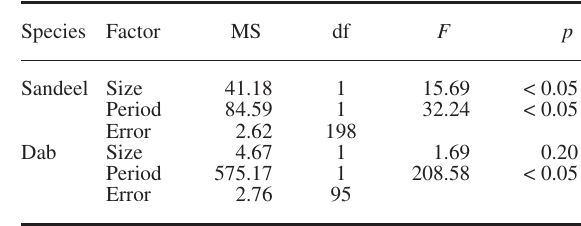
T ABLE 1. – Summary of the analyses of covariance (ANCOVA) on larval δ 15 N, the period of the sampling and larval standard length as covariable. Standard lengths of larval sandeel smaller than 200 µg, (approx. 10 mm standard length) and larval dab (approx. 6 mm) are the mean size of the larvae pooled to achieve enough material for the stable isotope analysis, individual data were used for larger larvae.